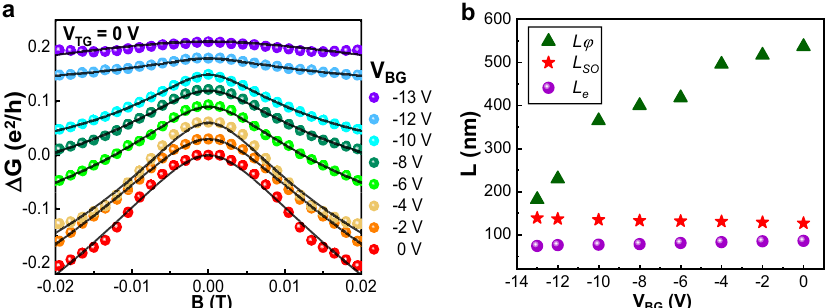
Fig. 2 Magnetotransport measurements at various bottom-gate voltages. a Low- fi eld magnetoconductance, Δ G ¼ G B ð Þ (cid:2) G ð B ¼ 0 Þ , measured for the device shown in Fig.1a at various bottom-gate voltages V BG at temperature T = 1.9 K. The bottom trace shows the measured magnetoconductance data at V BG = 0 V and all other measured magnetoconductance traces are successively vertically offset for clarity. Here the top-gate voltage is set at V TG = 0 V. The black solid lines are the theoretical fi ts of the experimental data to the HLN equation [Eq. (1)]. b Phase coherence length L φ , spin – orbit length L SO , and mean free path L e , in the InSb nanosheet extracted from the fi ts as a function of V BG